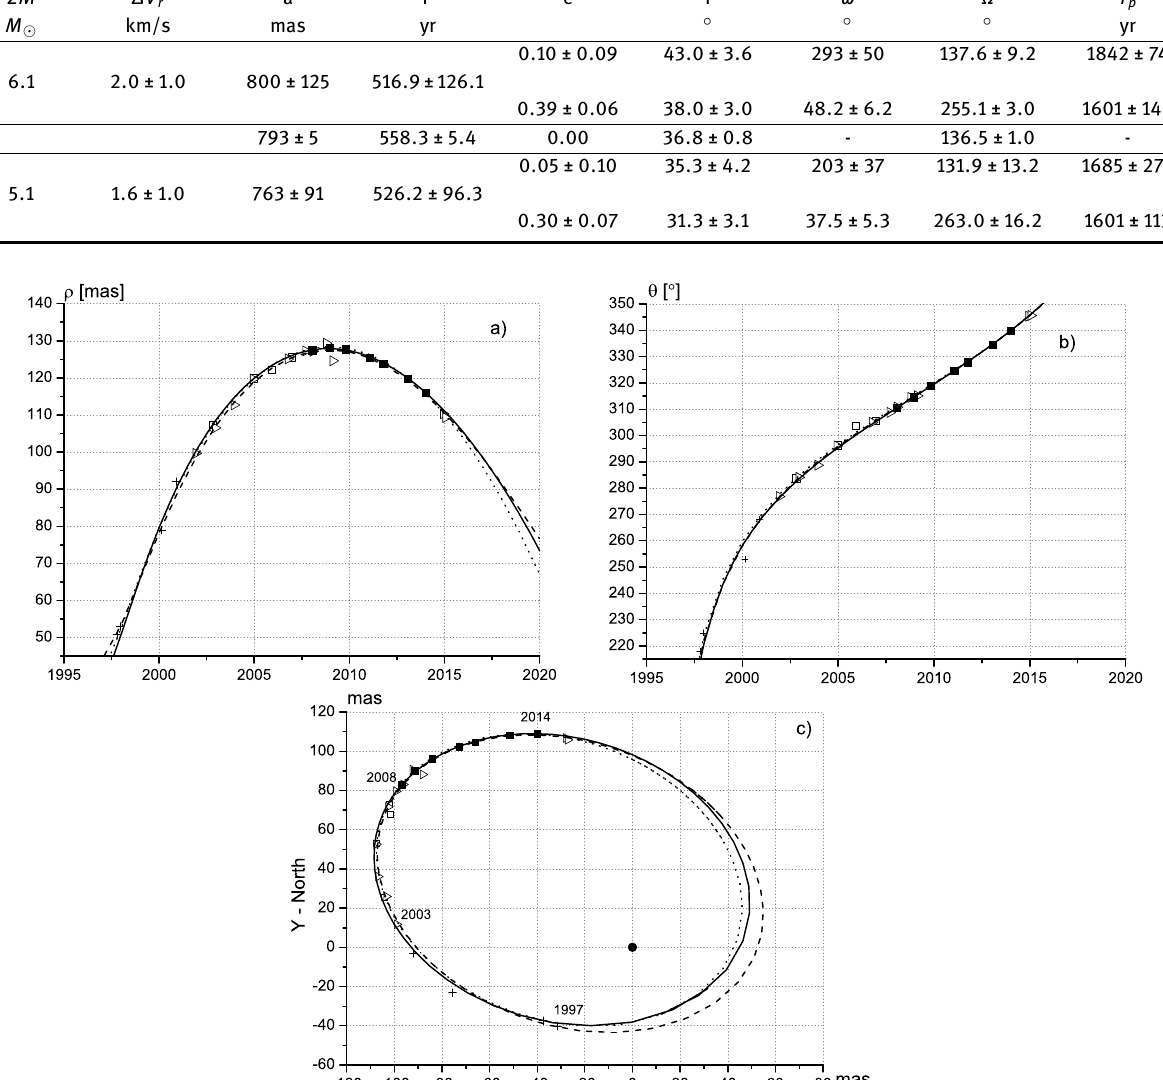
Table 4. The star T Tauri. The orbits of the outer pair N − S .